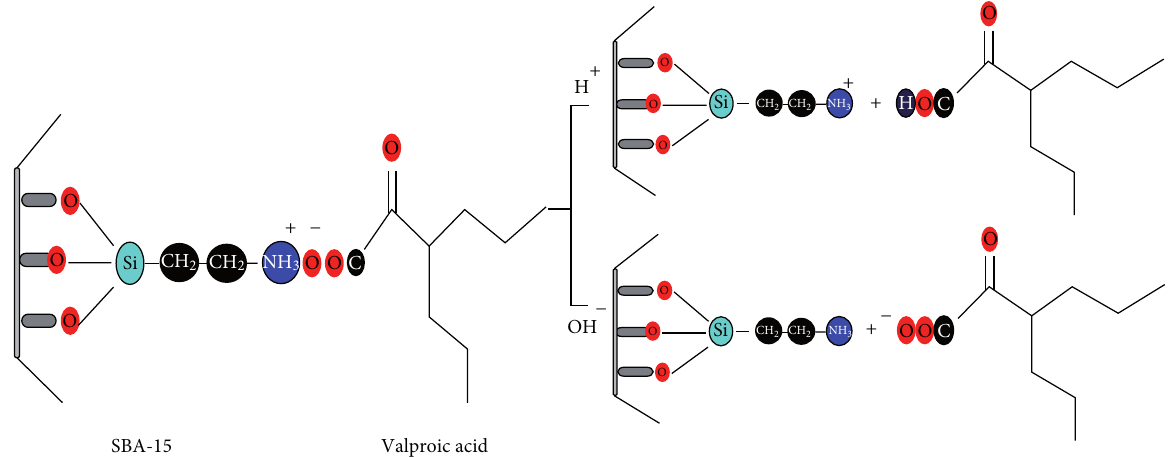
SBA-15-AP; a value of